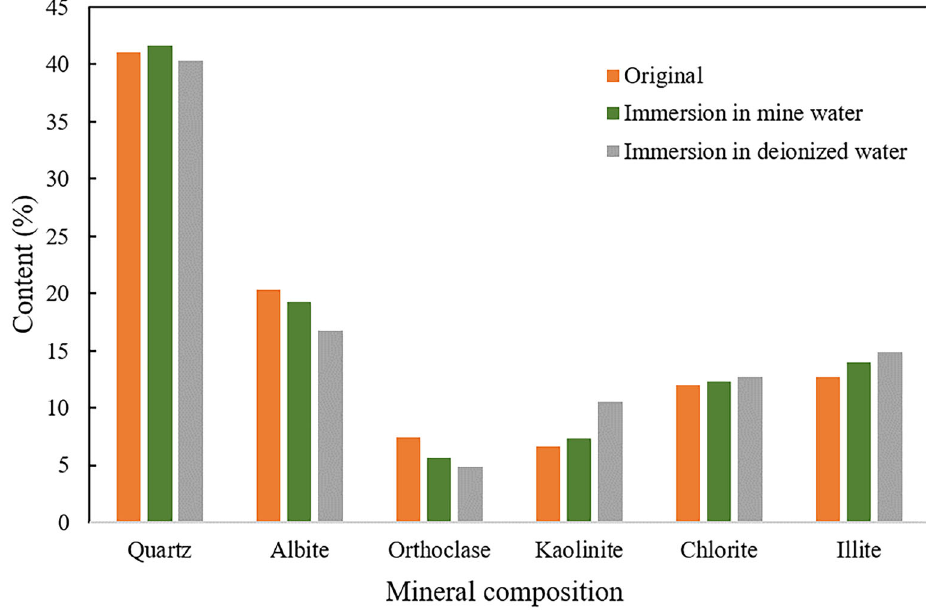
Fig. 9 The changes of mineral content in mudstone after the